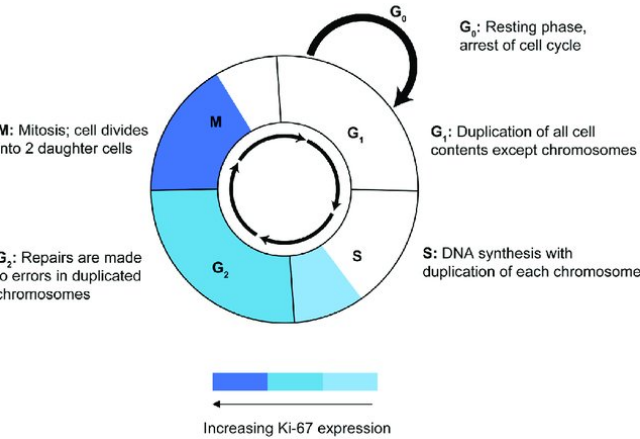
Figure 1. Schematic of Ki-67 expression during the cell cycle phases, peak expression and high staining intensity during the M phase [10].